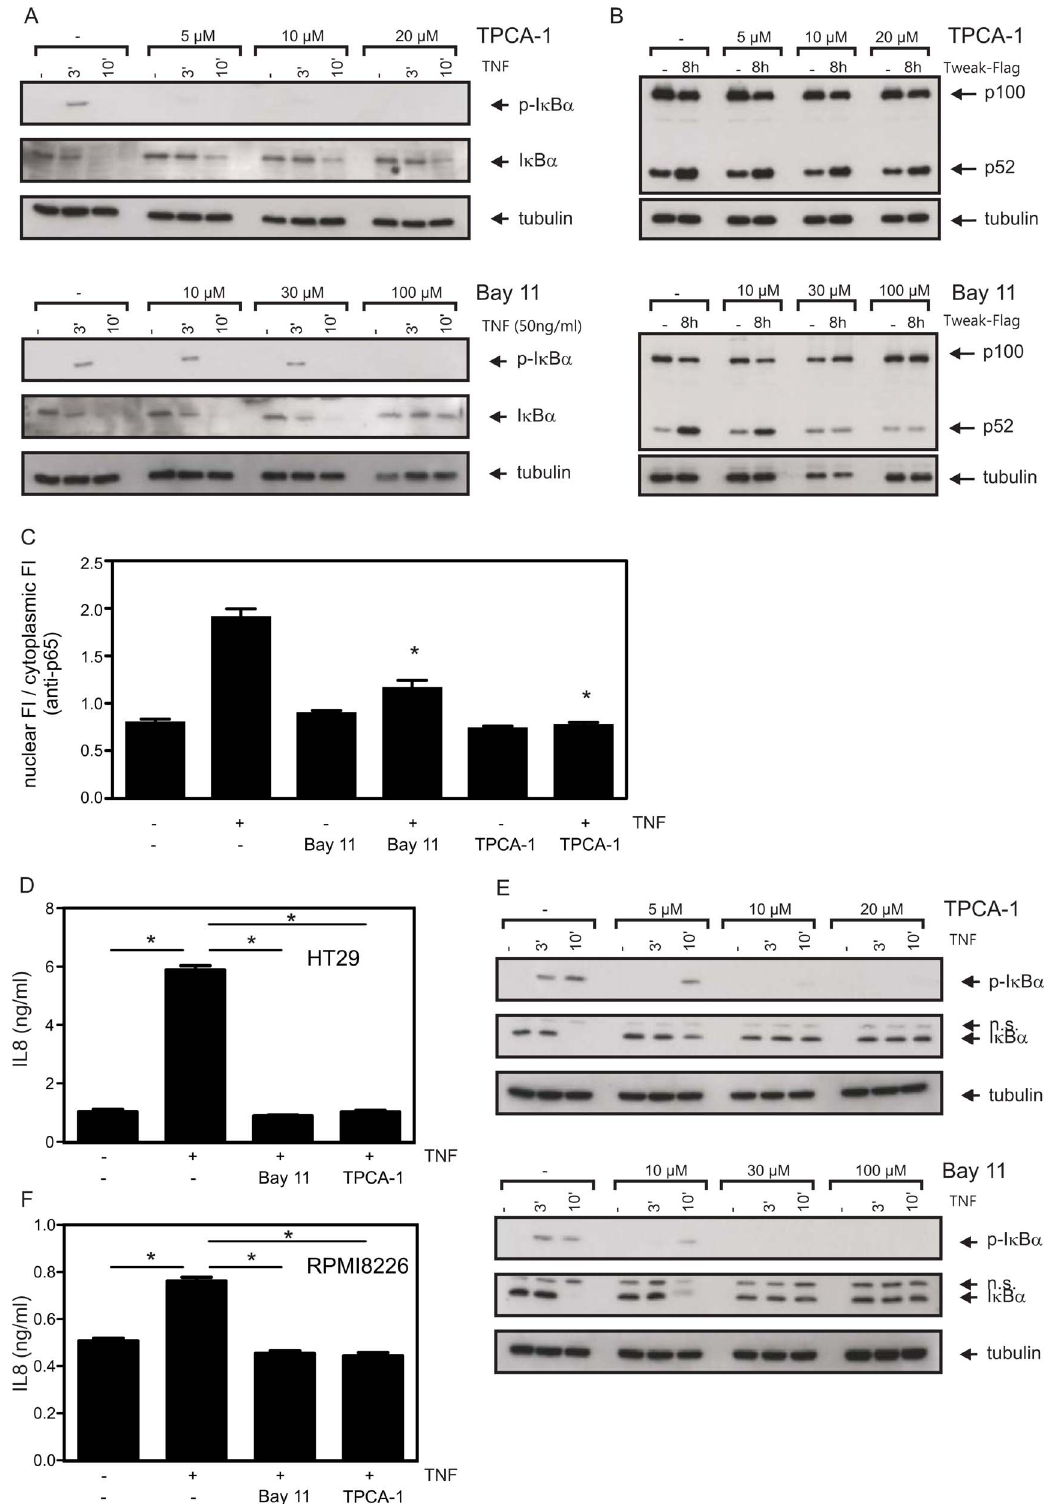
Figure 1. Functional titration of IKK inhibitors. (A,B) HT29 cells were pretreated for 1 h with the indicated concentrations of TPCA-1 and Bay 11- 7082 and were subsequently challenged with TNF (50 ng/ml) for 3 and 10 min (A) or with Flag-TWEAK (200 ng/ml) for 8 hours (B). Total cell lysates were finally analyzed by Western blotting with respect to TNF-induced phosphorylation and degradation of I k B a (A) and TWEAK-induced p100 processing (B). (C) HT29 cells (40,000/chamber) were grown on glass slides and were pretreated with Bay 11-7082 (30 m M) or TPCA-1 (20 m M) for 30 min. Cells were then challenged with 100 ng/ml TNF for 1 h. After immunofluorescence staining for p65, the ratio of nuclear to cytoplasmic fluorescence intensity (FI) was determined. Data shown corresponds to 95–111 analyzed cells per experimental condition derived from a total of four